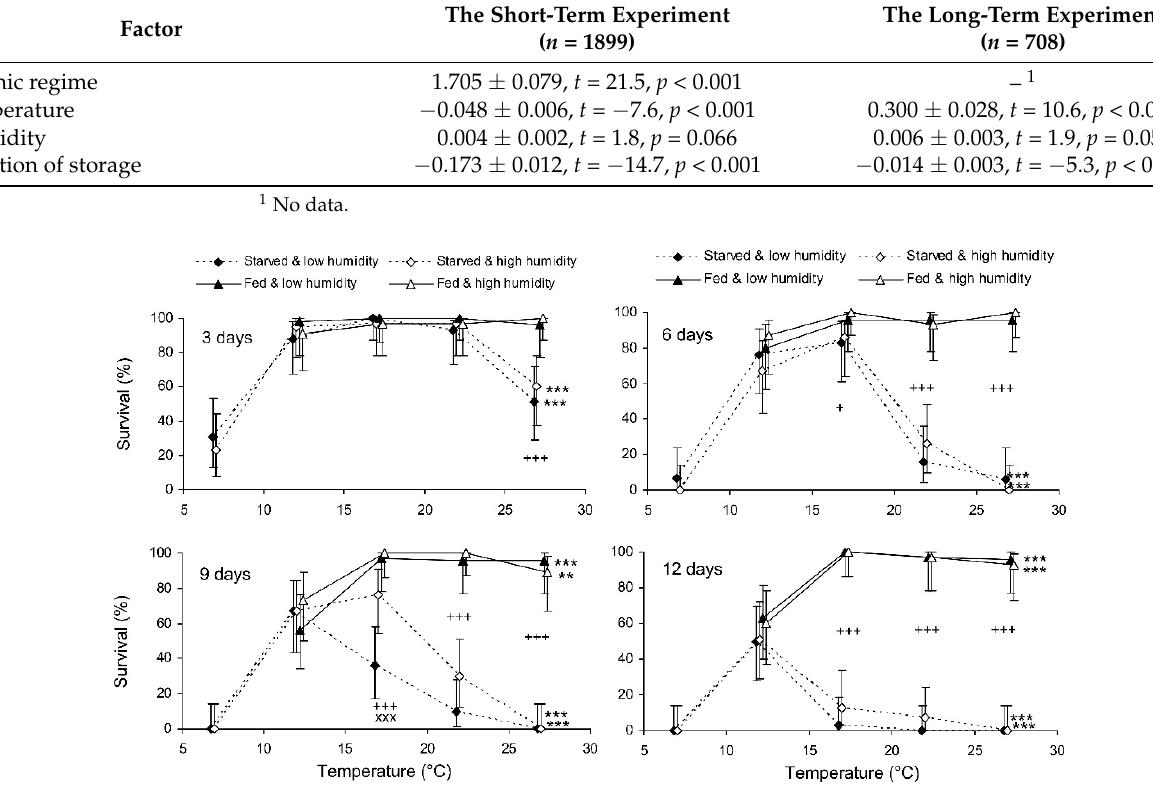
Figure 1. Survival of Cheilomenes propinqua females in relation to the temperature, humidity, trophic regime, and duration of storage (the results of the short-term experiment). Percentages with 95% confidence intervals are shown. The duration of storage is indicated in the graphs. Asterisks at the right end of the line indicate the significant influence of temperature: **— p < 0.01 or ***— p < 0.001 by the chi-square test. Plus symbols indicate a significant influence of the trophic regime at the corresponding temperature: +— p < 0.05, +++— p < 0.001, according to the Mantel–Haenszel chi-square test (humidity was used as a strata variable). X-crosses indicate the significant influence of humidity at the corresponding temperature, ×××— p < 0.001, according to the Mantel–Haenszel chi-square test (the trophic regime was used as a strata variable).